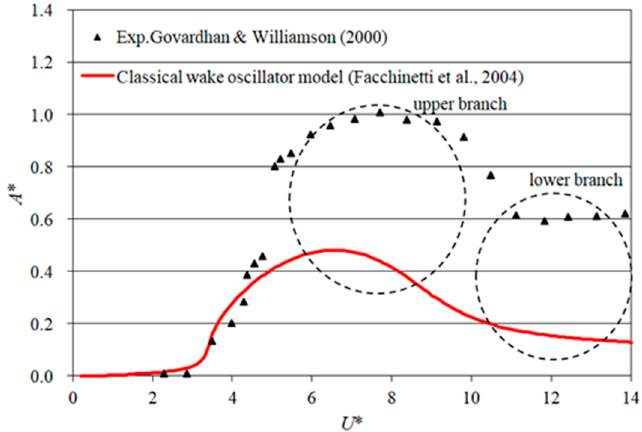
Figure 2. Comparing of the maximum transverse amplitude calculated by the classical wake oscillator model to the experimental data ( m * = 1.2, m* ζ = 0.006) [8,14].